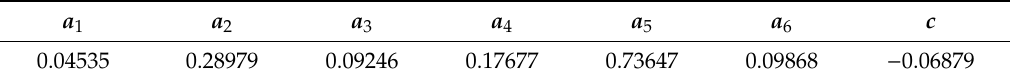
Table 5. Constants of the ROP empirical correlation (Equation (8)) for ANN models’ di ff erent transfer function